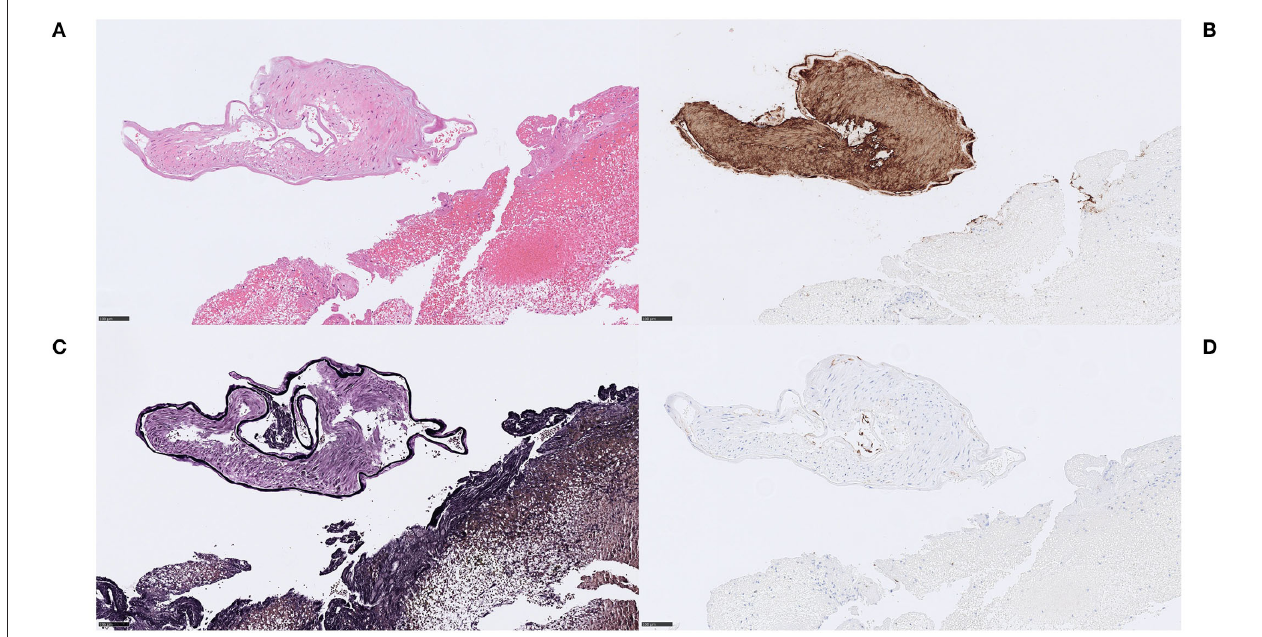
FIGURE 9 | Vascular wall. Case 6 Isolated piece of tunica media with well-developed elastic lamina-like structure, no apparent pathological tunica intima and no evidence of tunica adventitia (A) H&E, 200x. The tunica media stained positive on the smooth muscle marker anti- α -SMA-immunostain, confirming smooth muscle cells (B) α -SMA, 200x. MSB staining indicated presence of thin collagen fibers between the smooth muscle cells (not shown). As suspected, Verhoeff van Gieson stained the morphologically identified internal elastic lamina in a dense, dark and linear fashion (C) Verhoeff van Gieson, 200x. A few endothelial cells could be seen resting on the elastic lamina in immunohistochemical stains with the endothelial marker CD34. These findings point to a conclusion of thrombectomized material of a healthy arterial wall, in this case most likely accidentally damaged during MT. (D) CD34, 200x. Scale bar = 100 µ